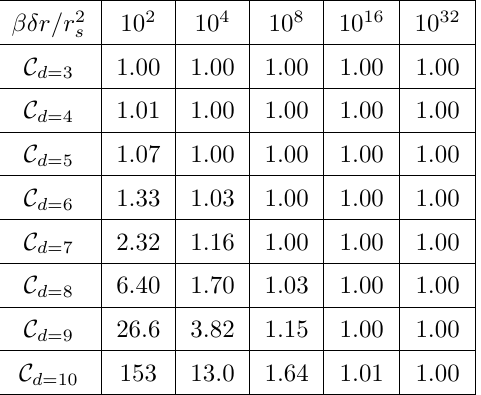
Table 2 . We are setting r s /L = 0 (asymptotically flat black holes or very small AdS black holes). We are computing C d which is the ratio between the numerical calculation of eq. (2.25) divided by the approximated result given by eq. (2.34) for spacetime dimension d + 1 . We can see that for larger values of β the estimate for the evaporation rate using only ‘ = 1 mode becomes more precise. This is because of the for larger β the ‘ = 1 mode is dominant compared to all the ‘ > 1 modes.